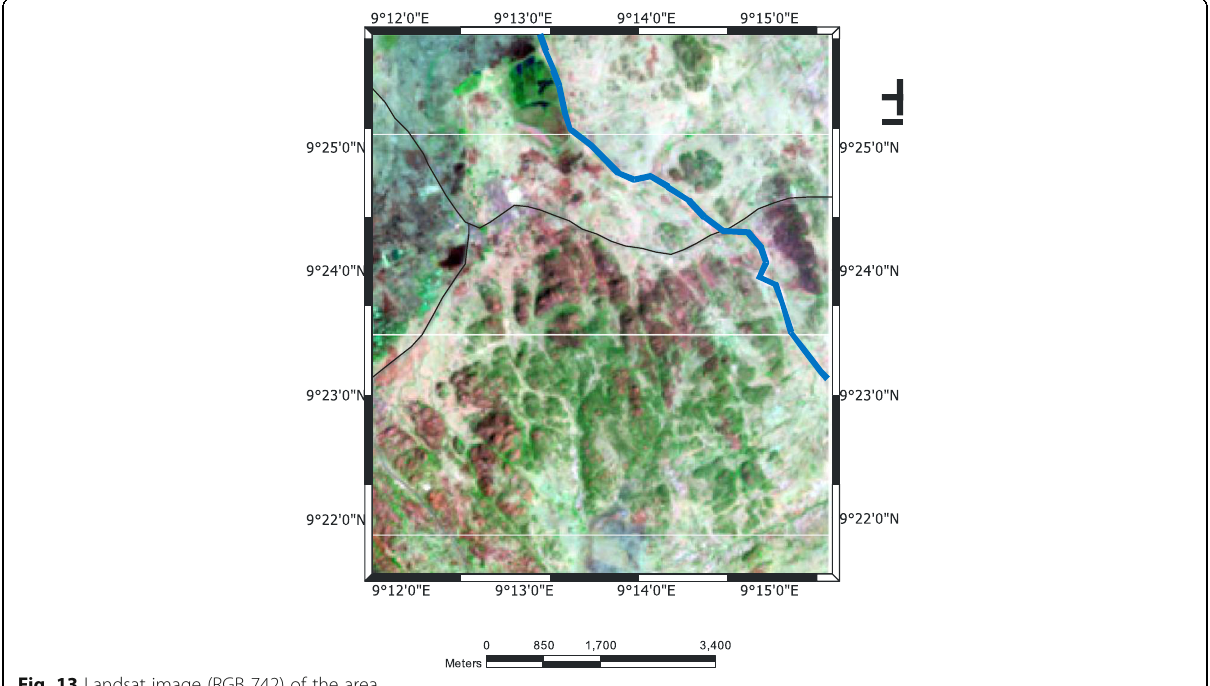
Fig. 13 Landsat image (RGB 742) of the